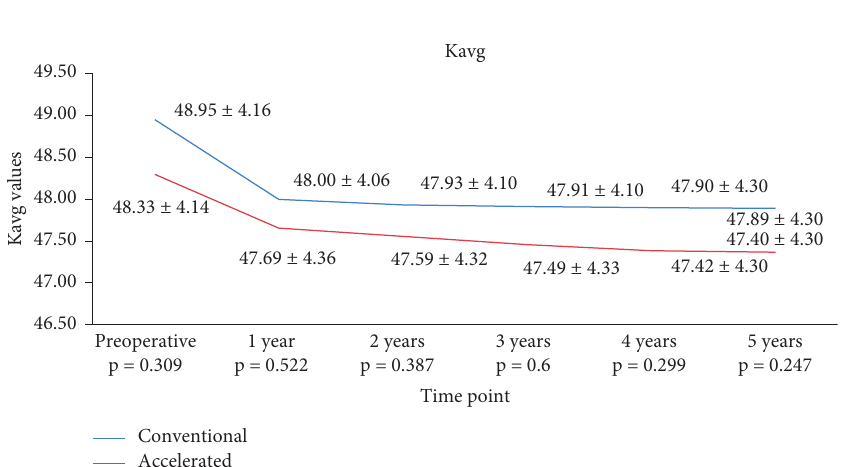
Figure 2: Evolution of Ksteep in both groups.